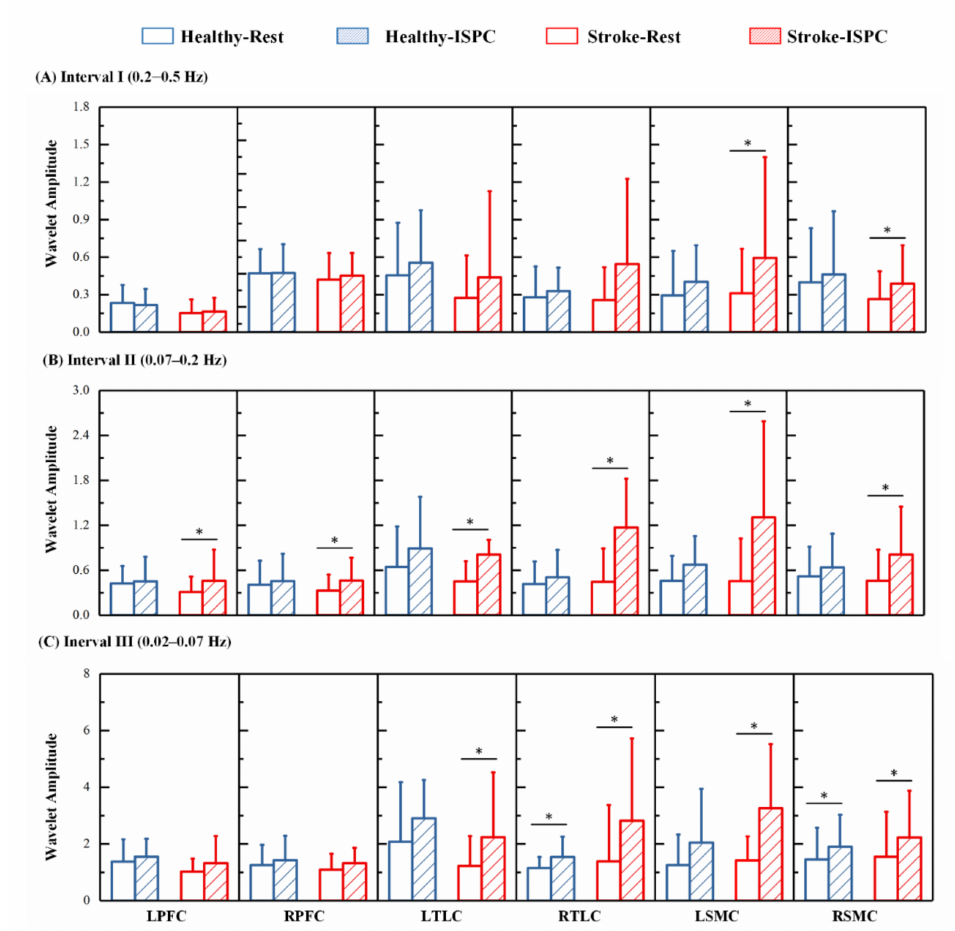
Figure 4. Comparison of the mean wavelet amplitudes of ∆ [O 2 Hb] signals and the associated standard deviations for each group in each state is shown in ( A ) interval I, ( B ) interval II, and ( C ) interval III. Significant differences are marked with ∗ ( p <